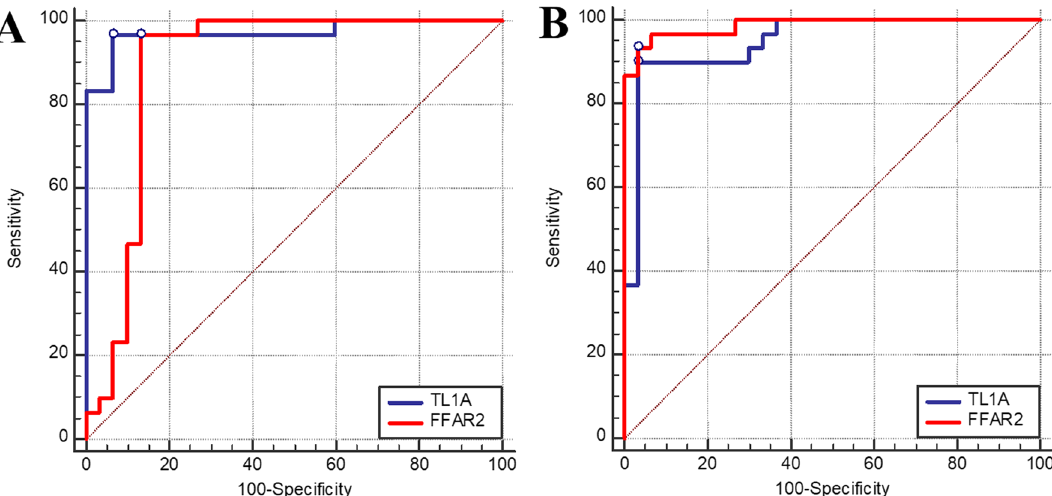
Fig. 2 Receiver operating characteristics (ROC) curve illustrating the diagnostic value of TL1A and FFAR2 in discriminating A SA from controls and B SA from UA. FFAR2 free fatty acid receptor 2, SA stable angina, TL1A tumor necrosis factor like cytokine 1A, UA unstable angina